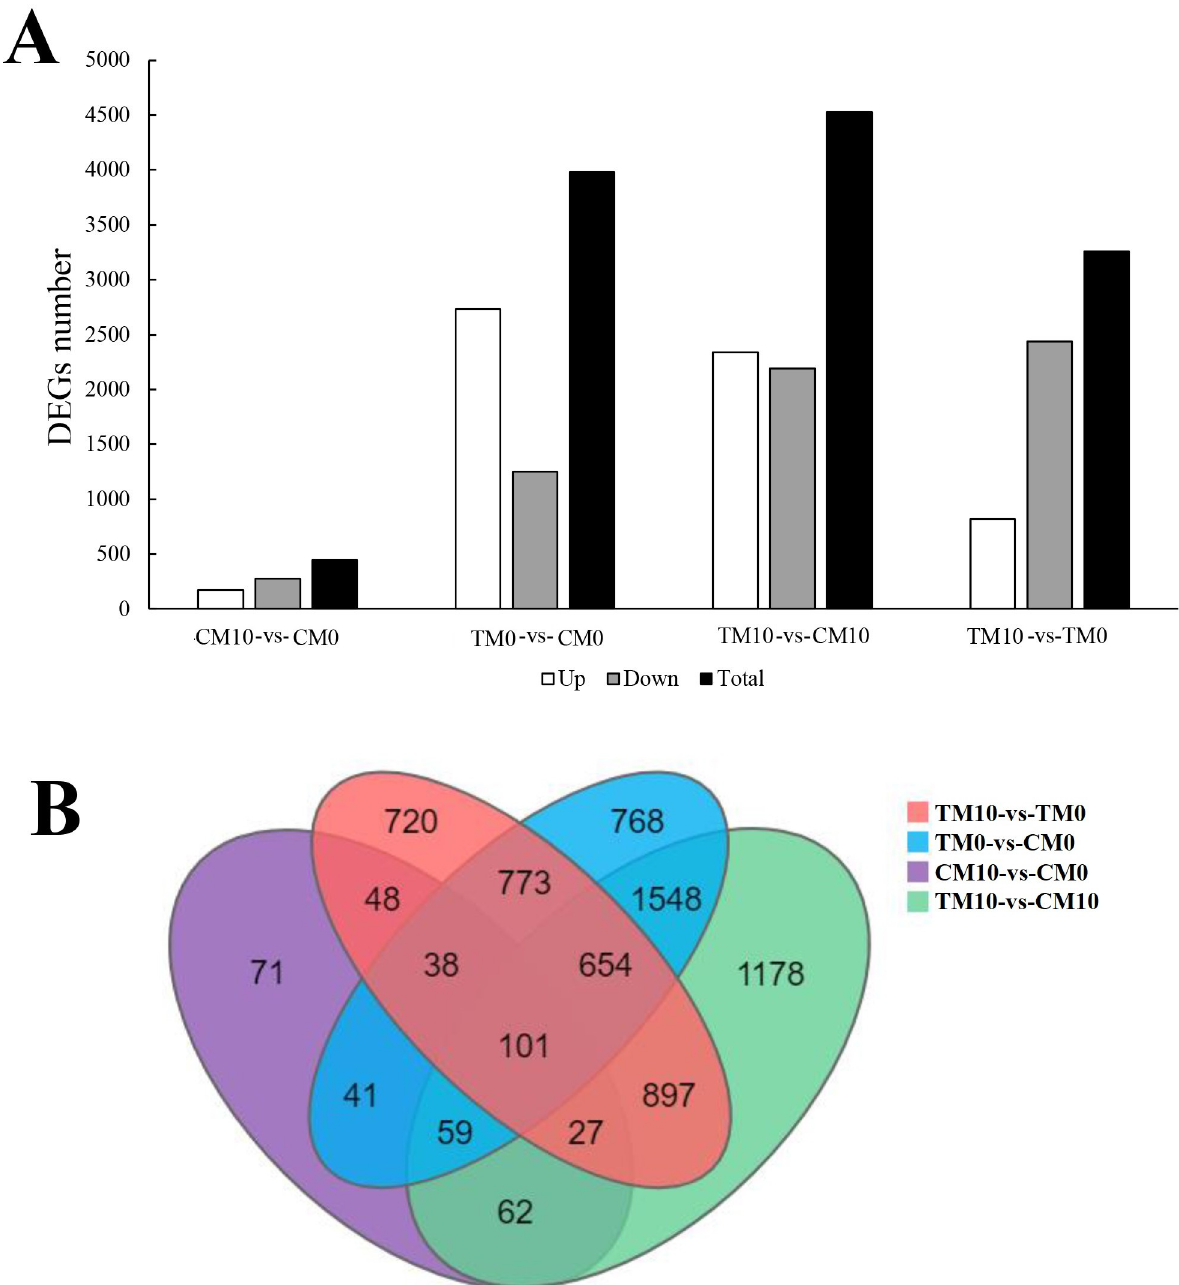
Fig 3. The number of DEGs in the four comparison groups (CM10-vs-CM0, TM0-vs-CM0, TM10-vs-CM10, TM10-vs-TM0) and venn diagram analysis. A. The total DEGs number and DEGs numbers of up-regulated as well as down-regulated genes in the four groups. B. Venn diagram analysis of the DEGs numbers in the four